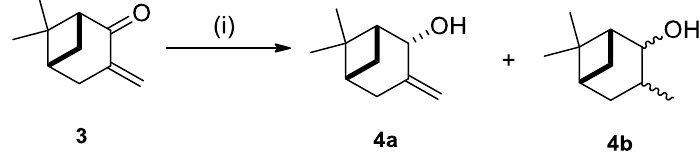
Scheme 2. (i) NaBH4 (2 equ.) and CeCl3.7H2O (1 equ.), 0 ◦ C, 0.5 h, Table 1. Stereoselective reduction of 3 according to Scheme 1. Table 1. Stereoselective reduction of 3 according to Scheme 1.